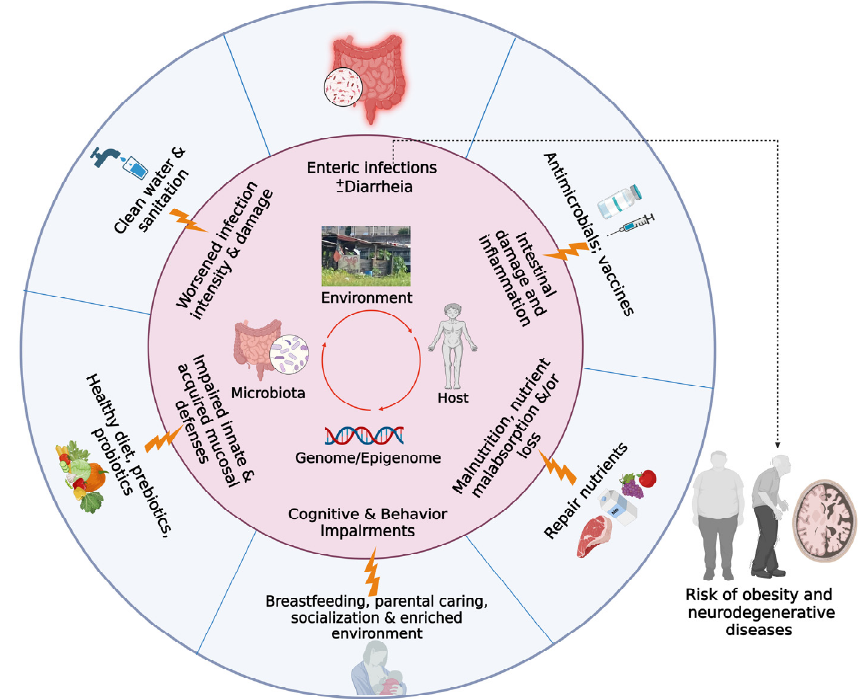
Figure 1. Overview of the vicious cycle of malnutrition and enteric infections (even without diarrhea) early in life. Complex interactions of contaminated environments, gut microbiota dysbiosis, and the hosts genome/epigenome may lead to lasting health effects, including intestinal barrier breakdown and inflammation, poor immune responses against enteric pathogens, and circulating gut born LPS to the brain during critical times of development with cognitive/behavioral impairments. If chronic and persistent, this vicious cycle could increase the risk for cardiovascular and neurodegenerative diseases later in life. In-place continuous interventions, including access to potable water, sanitation, vaccines, and healthy diets, are needed to ameliorate and possibly reverse such deleterious effects. Figure created with BioRender.com.